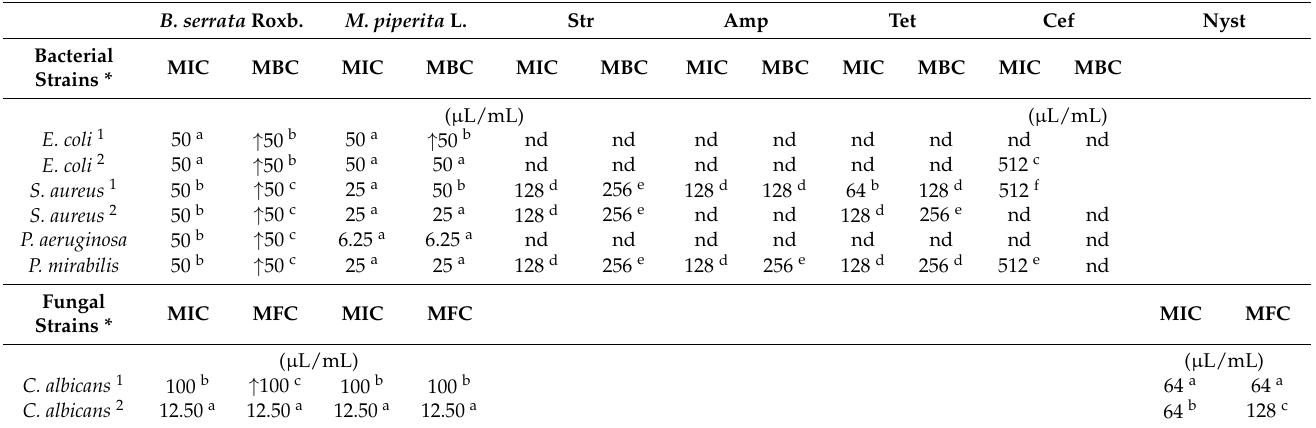
Table 1. MIC and MBC/MFC values ( µ L/mL) of EOs against bacterial and Candida